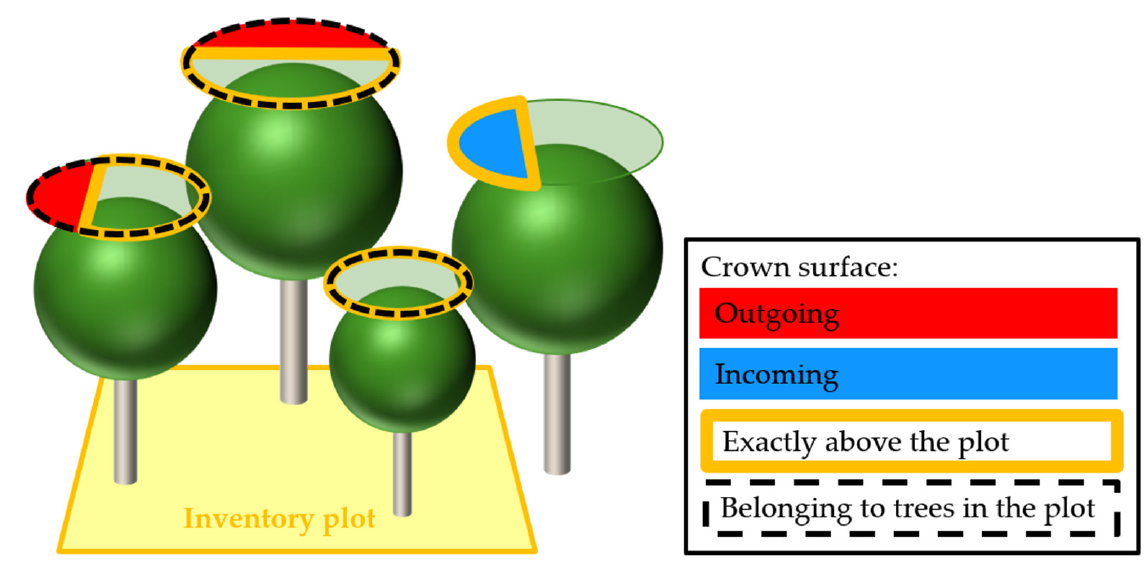
Figure 1. Illustration of the crown surface fractions. The plot area is indicated by the yellow square. The transparent green circles above the trees indicate the crown projection areas. The coloring marks the outgoing (red) and incoming (blue) parts of the crowns, as well as the crown surface exactly above the plot (orange border) and the crown surface belonging to trees in the plot (black dashed border).